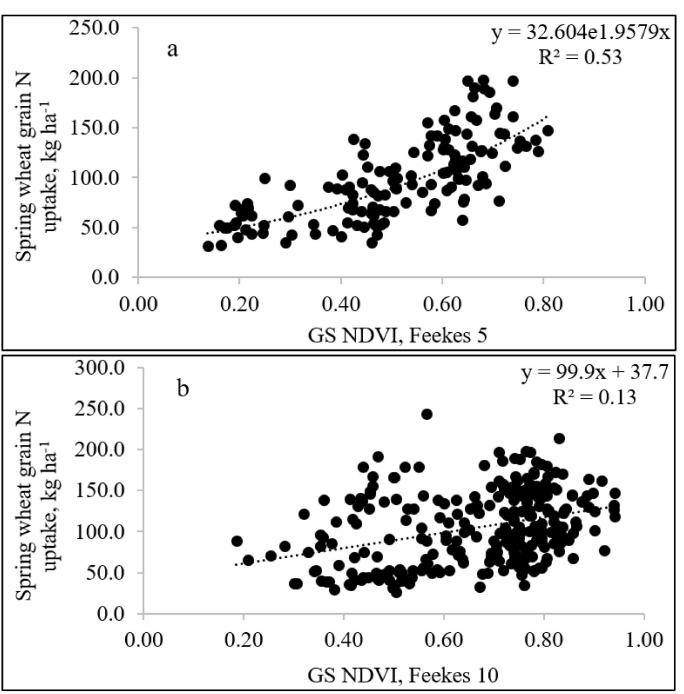
Figure 5. Relationship between Normalized Difference Vegetative Index (NDVI) at Feekes 5 ( a ) and Feekes 10 ( b ) growth stages collected using the GreenSeeker (GS) sensor and spring wheat grain N uptake (kg ha − 1 ), for fourteen site-years in Idaho,